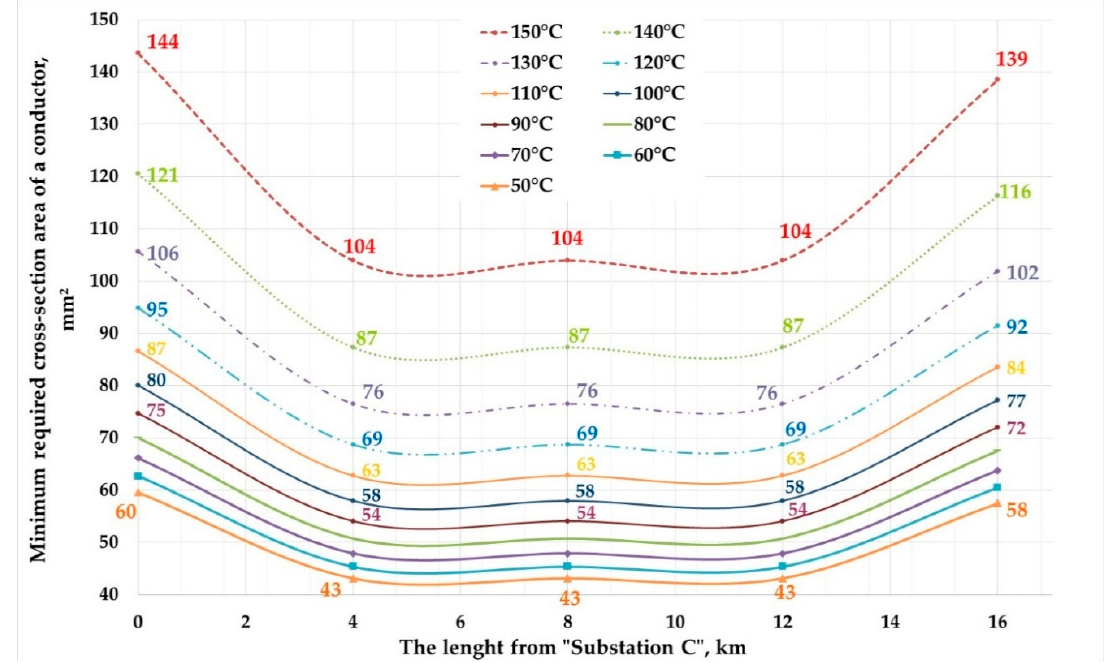
Figure 9. Identification of overlaps of cross-sectional areas of conductor for “OHL No.2”.